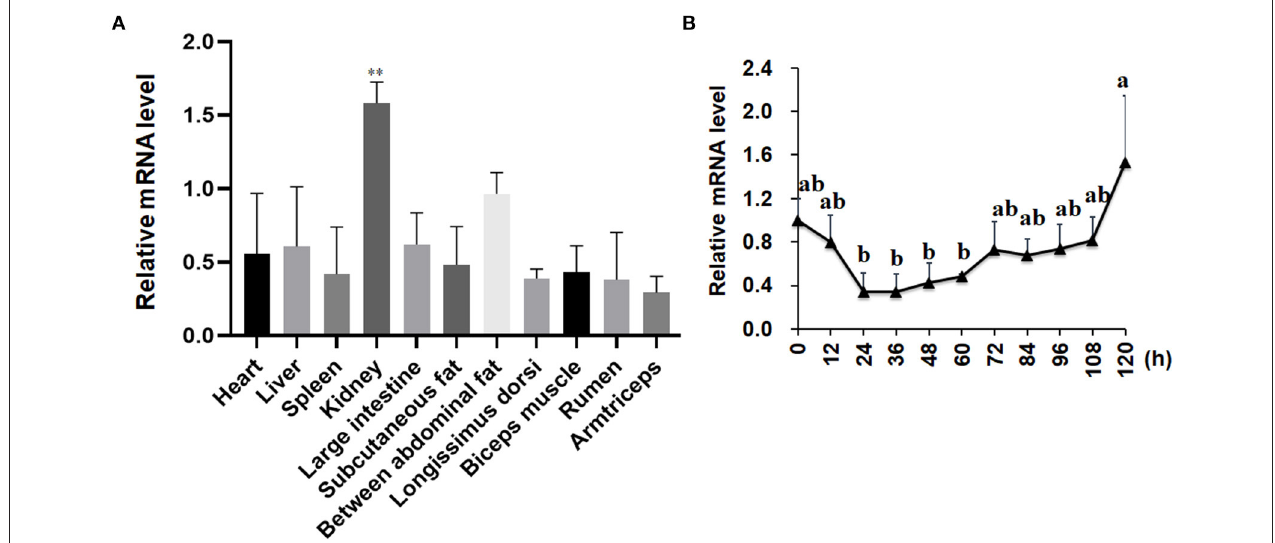
FIGURE 2 | The mRNA expression patterns of the LKB1 gene in goat tissues and during intramuscular adipocyte differentiation. (A) The LKB1 mRNA level in heart, liver, spleen, kidney, large intestine, subcutaneous fat, between abdominal fat, longissimus dorsi, biceps muscle, rumen, and arm triceps, n = 6. Ribosomal protein lateral stalk subunit P0 ( RPLP0 ) as the internal reference gene. (B) The LKB1 mRNA level at day 0, 12, 24, 36, 48, 60, 72, 84, 96, 108, and 120h in induced differentiation intramuscular adipocyte ( n = 6), both UXT and PPIB are as reference genes. ** P < 0.01 , the LKB1 level of kidney compared to other tissues. Different letters indicate the significant difference ( P < 0.05), and the same lowercase indicates an insignificant difference ( P > 0.05). LKB1, liver kinase B1.